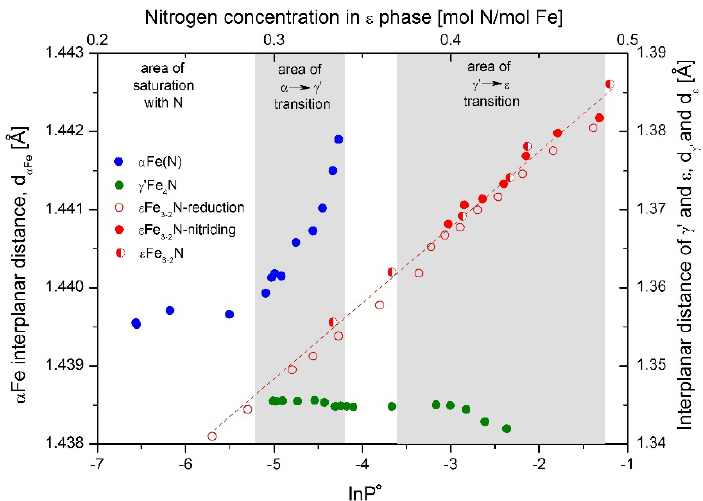
Figure 2. Dependence of the interplanar spacing, d, of α , γ (cid:48) and ε phases on the nitriding potential. Areas of two phase stability, in which phase transitions of α → γ (cid:48) (lnP ◦ = − 5.2— − 4.2) and γ (cid:48) → ε (lnP ◦ = − 3.6— − 1.3) in nitriding process take place, are marked in gray. Interplanar distance of γ (cid:48) Fe 4 N, d γ (cid:48) , change slightly, in a small range, as long as the